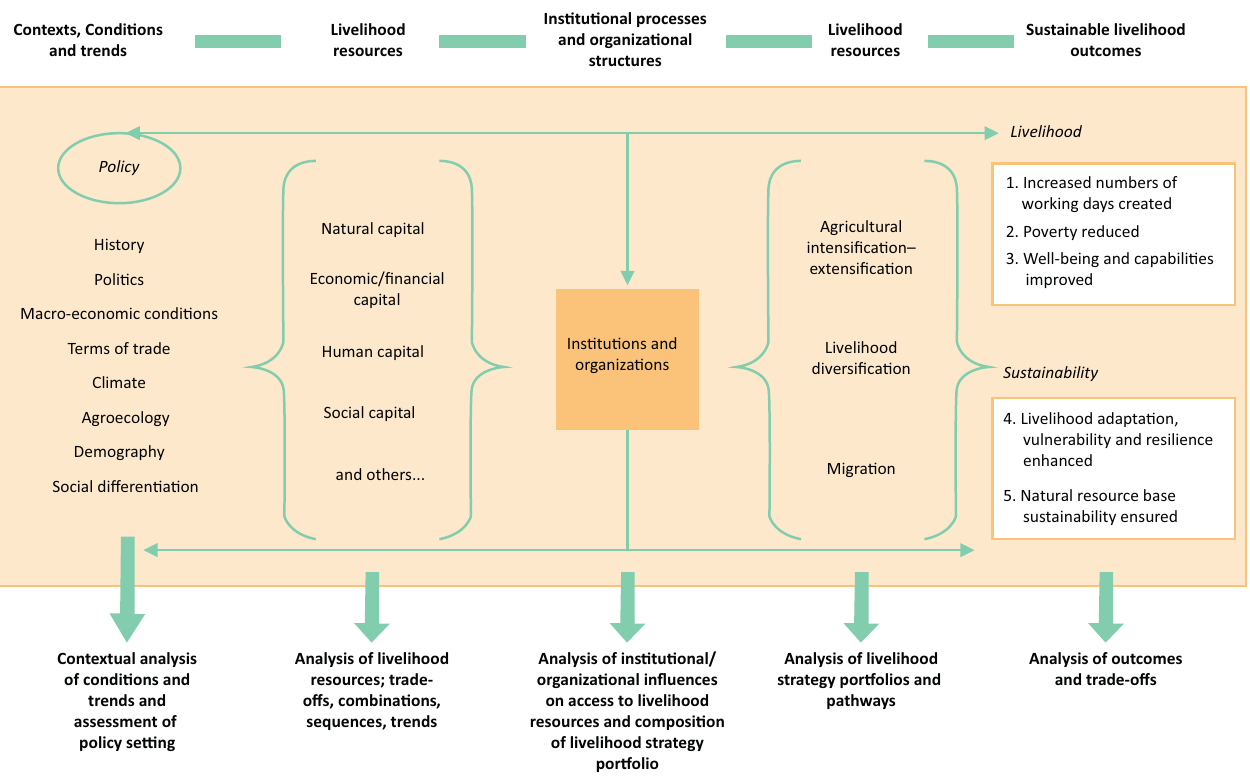
Contexts, Condi(cid:20)ons and